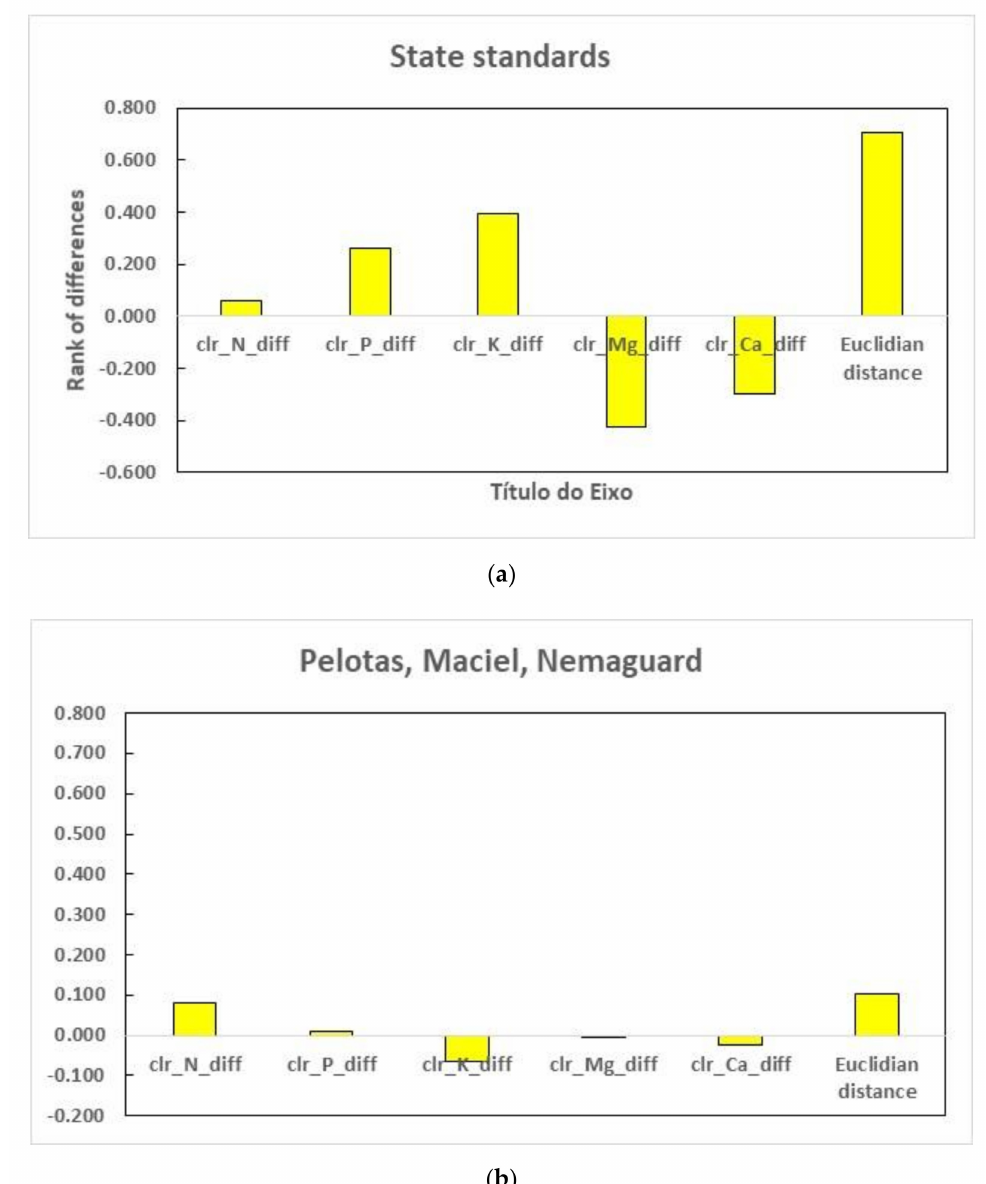
Figure 4. Histograms showing contrasting macronutrient diagnoses of a low-yielding peach orchard between ( a ) state standards and ( b ) the closest neighbor in Pelotas, Rio Grande do Sul, Brazil (same location and cultivar, similar soil properties and number of chilling hours). The centered log ratio ( clr ) di ff erences are computed as clr values of the diagnosed specimen (yield of 8.9 Mg ha − 1 ) minus the corresponding clr values of (left) state standards (no yield target indicated) or (right) the closest successful specimen (yield target of 30.4 Mg ha − 1 ). The Euclidian distance is computed across clr di ff erences. Negative di ff erences between defective and successful specimens indicate relative shortage. Positive di ff erences indicate relative